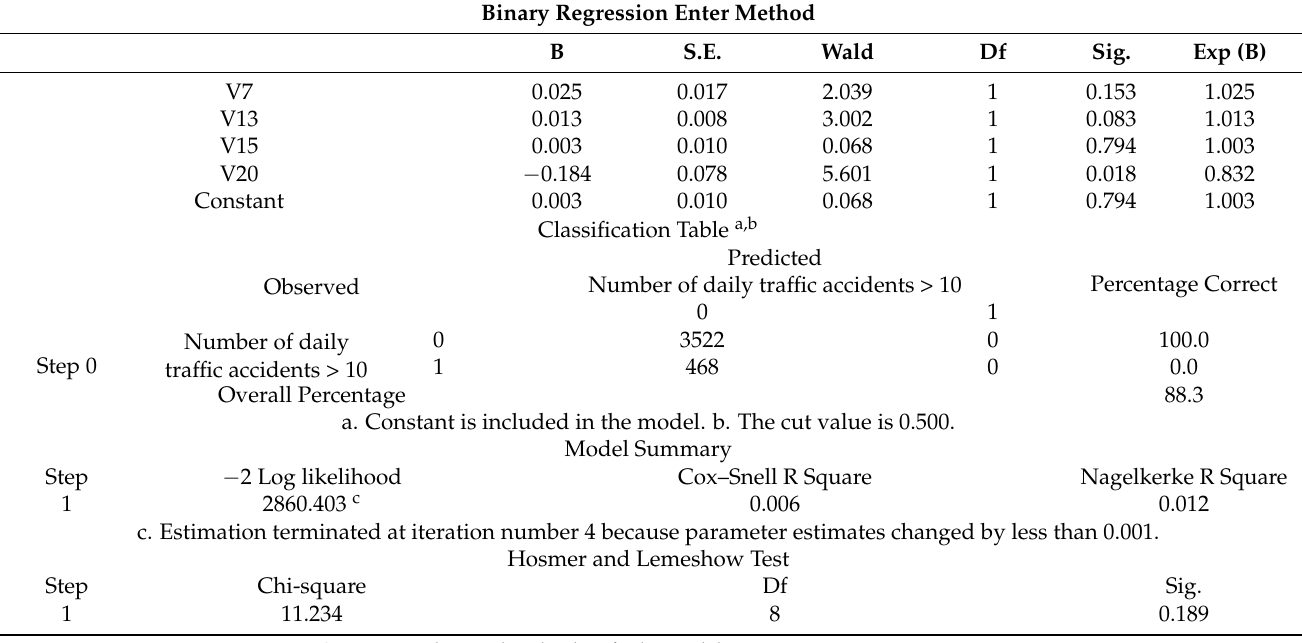
Table 7. Results of the binary regression Enter method using the 4 selected attributes.